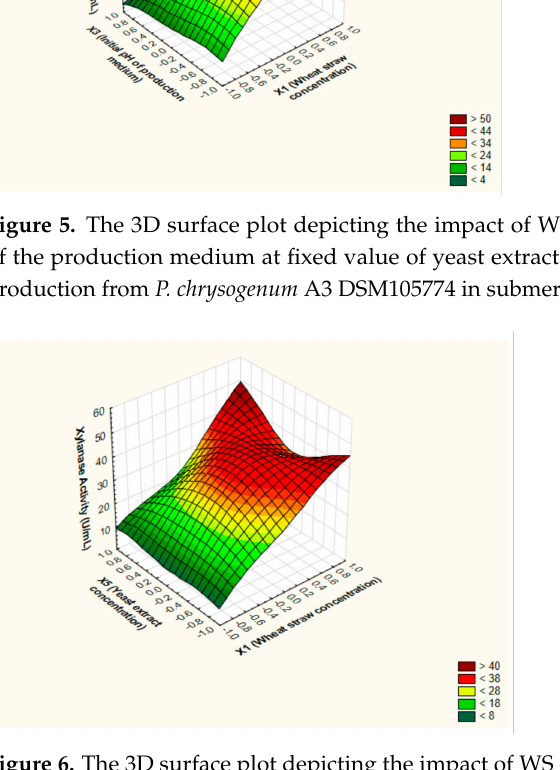
Figure 6. The 3D surface plot depicting the impact of WS concentration (%( w / v )) and yeast extract concentration (%( w / v )) at a fixed value of initial pH of the production medium on the xylanase